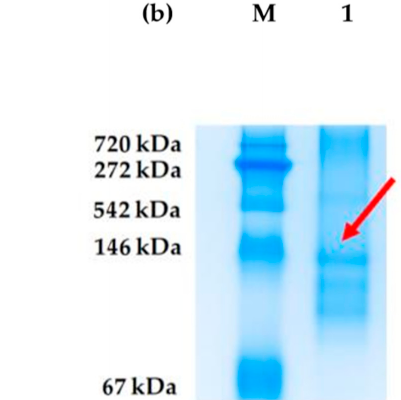
Figure 6. ( a ) SDS-PAGE analysis of purified recombinant GAD from L. plantarum FNCC 260 expressed in E. coli. Lane M; protein marker, 1; purified GAD. The arrow indicated GAD with molecular masses of approximately 53 kDa. ( b ) Native PAGE analysis of purified recombinant GAD. The molecular masses of GAD were estimated to be 140 kDa, Lane M; protein marker, 1; purified